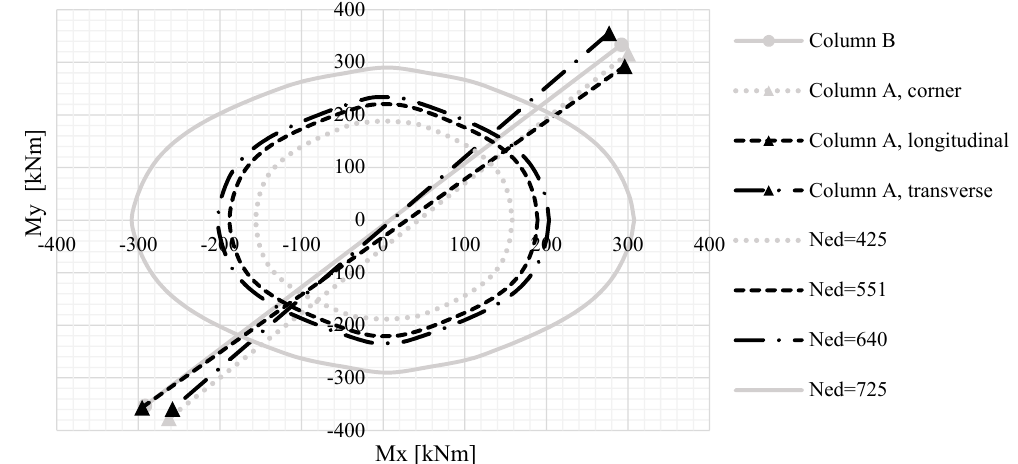
Figure 12. Resistance domains for columns of the static scheme with roof rigid slab.